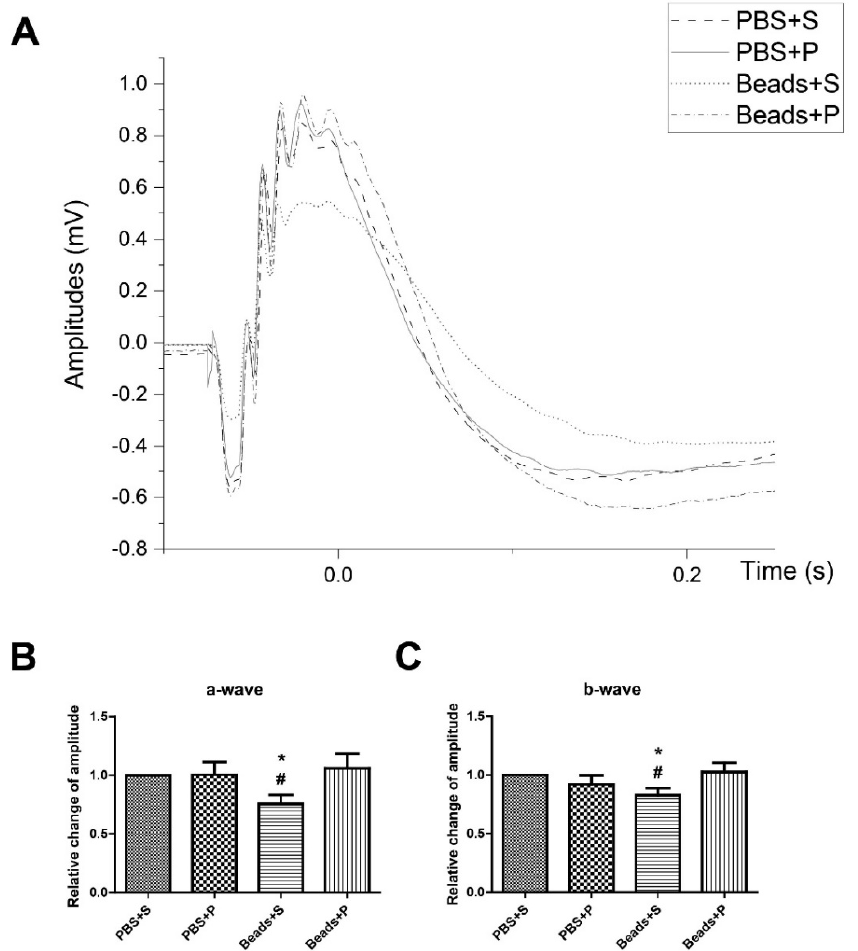
Figure 4. ( A ) Representative average ERG recordings of PBS + S, PBS + P, Beads + S, Beads + P groups. ( B , C ). Comparative analysis of the amplitude ratio of a-wave ( B ) and b-wave ( C ). ERG responses were similar in PBS + S and PBS + P rats under healthy conditions. Microbead-induced alterations (Beads + S) in the amplitudes of a- and b-waves compared to the control animals (PBS + S). ERG showed significant functional protection after PACAP1-38 eye drops treatment (Beads + P) in the microbead-injected eye compared to the Beads + S group. Data are given as mean ± SEM, analyzed by ANOVA and Fisher’s post hoc test. * Beads + S vs. PBS + S p < 0.05; # Beads + S vs. Beads + P p < 0.05. (Abbreviations: ERG: electroretinography; PBS: phosphate-buffered saline; S: Systane; P: PACAP1-38).